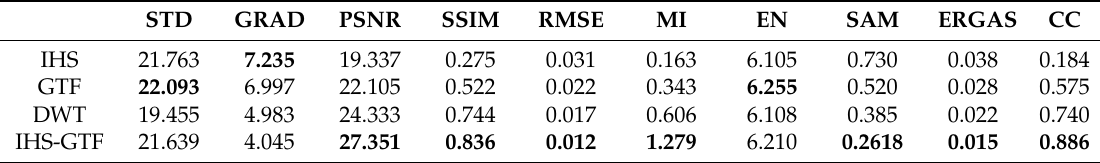
Table 2. Evaluation of fusion results for Site 1. The best results for each quality measure are in bold.